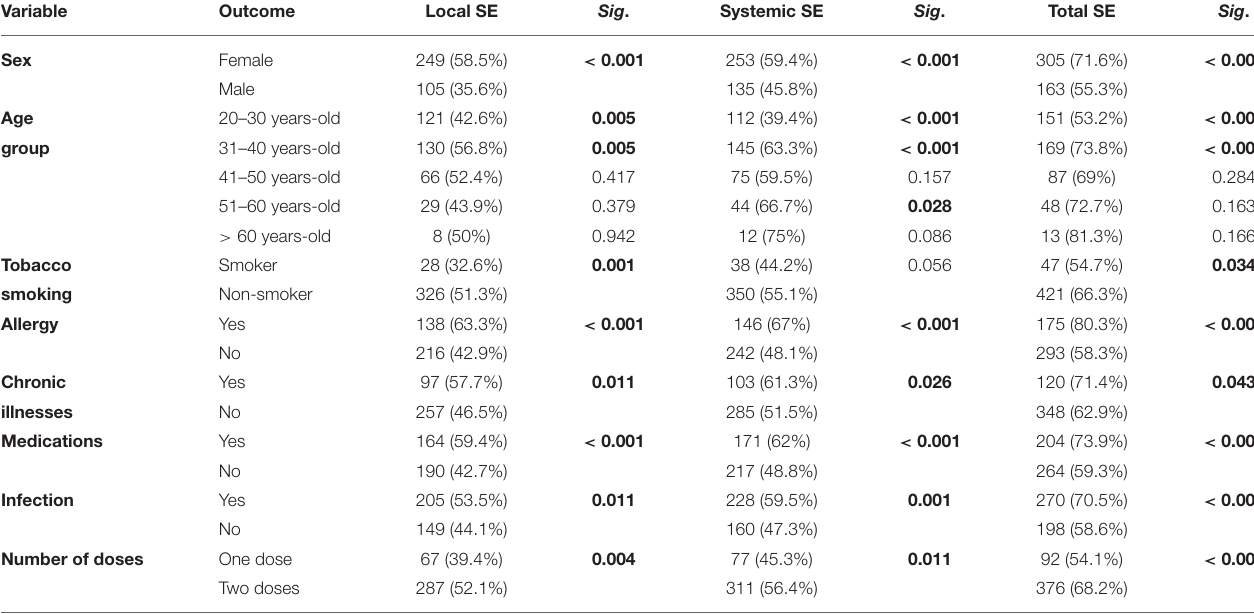
TABLE 6 | Risk factors of post-vaccination side effects reported by Algerian healthcare workers ( n = 721). Variable